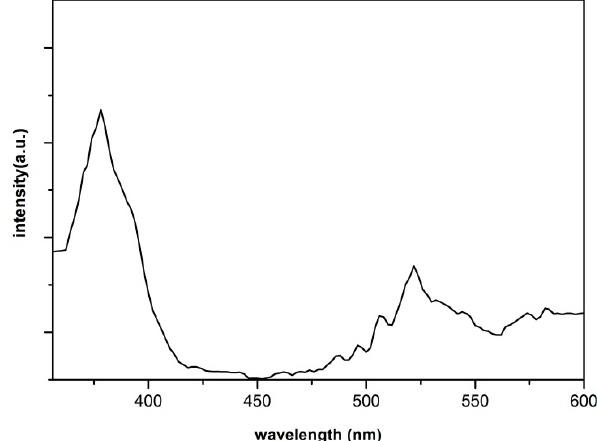
Figure 5. Room temperature’s PL spectrum of the ZnO nanowires prepared by the oxidation of Zn thin films at 600